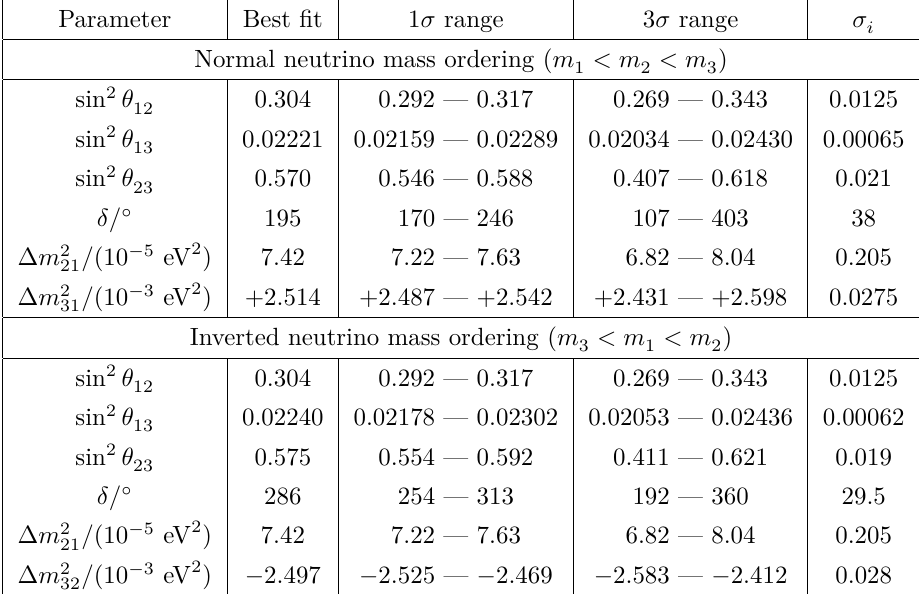
Table 2 . The best-fit values, the 1 σ and 3 σ intervals, together with the values of σ symmetrized 1 σ uncertainties, for three neutrino mixing angles { θ squared differences { ∆ m 2 analysis of current experimental data